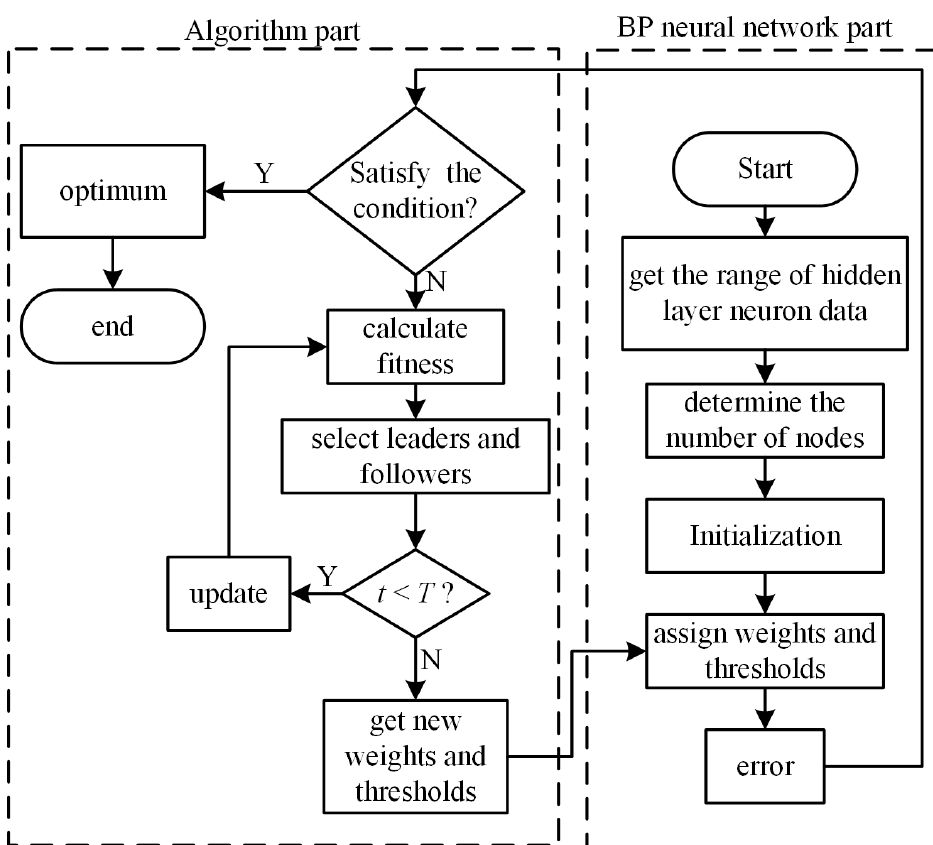
Figure 2. SSA2-BP neural network algorithm flow chart.